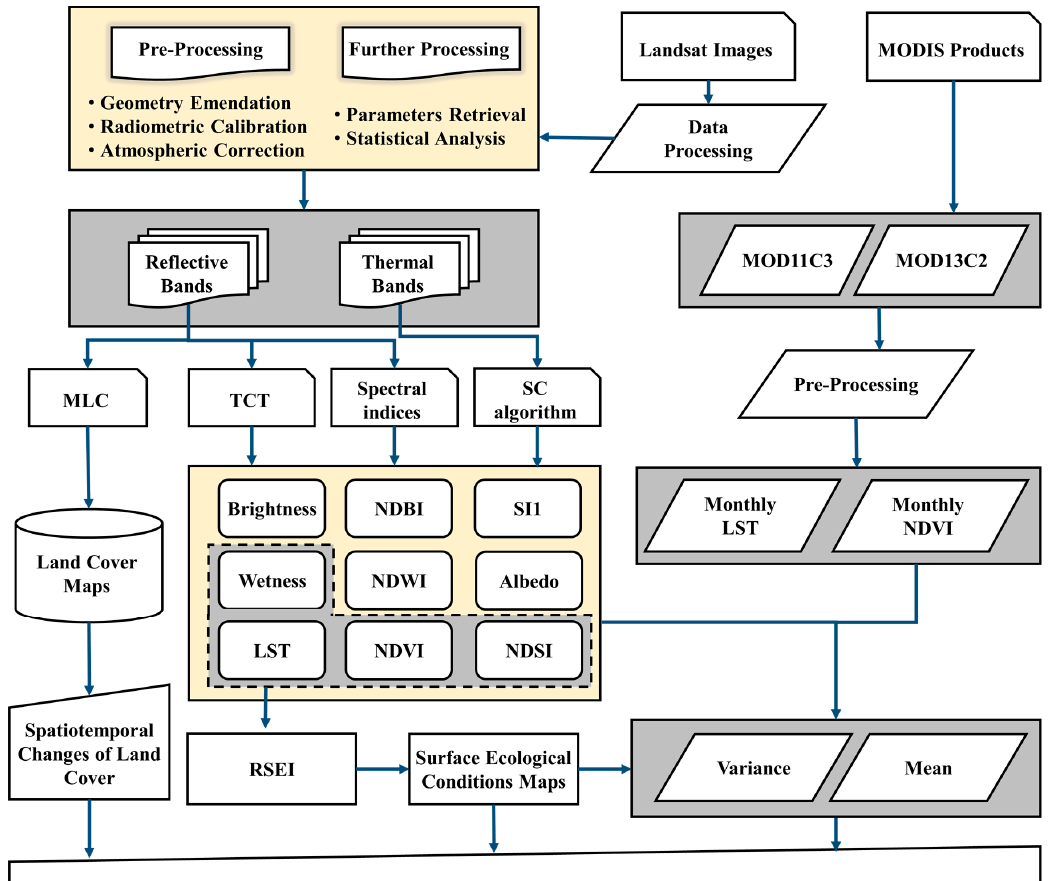
Figure 2. Conceptual framework and flow of the study. Note: MLC: Maximum Likelihood Classification; TCT: Tasseled Cap Transformation; SC: Single - Channel; NDBI: Normalized Difference Built-up Index; SI1: Salinity Index 1; NDWI: Normalized Difference Water Index; LST: Land Surface Temperature; NDVI: Normalized Difference Vegetation Index; NDSI: Normalized Difference Salinity Index; RSEI: Remote Sensing-based Ecological Index.